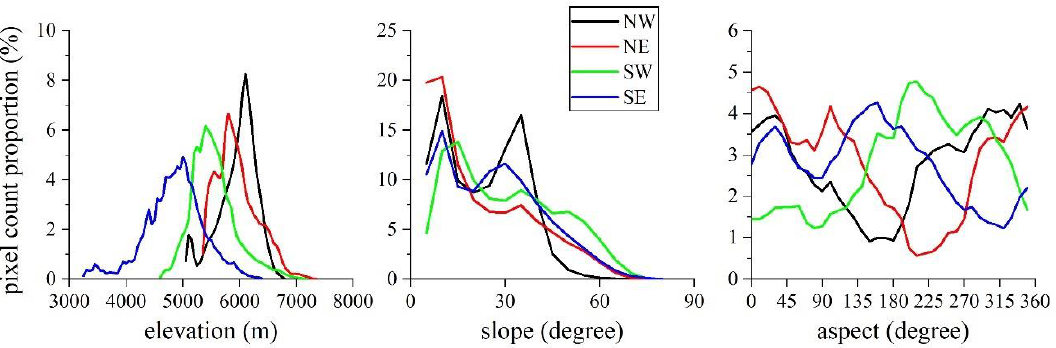
Figure 2. Line charts of the elevation, slope, and aspect distribution of the four glaciers. The black, red, green, and blue curves are for the NW, NE, SW, and SE glaciers, respectively.